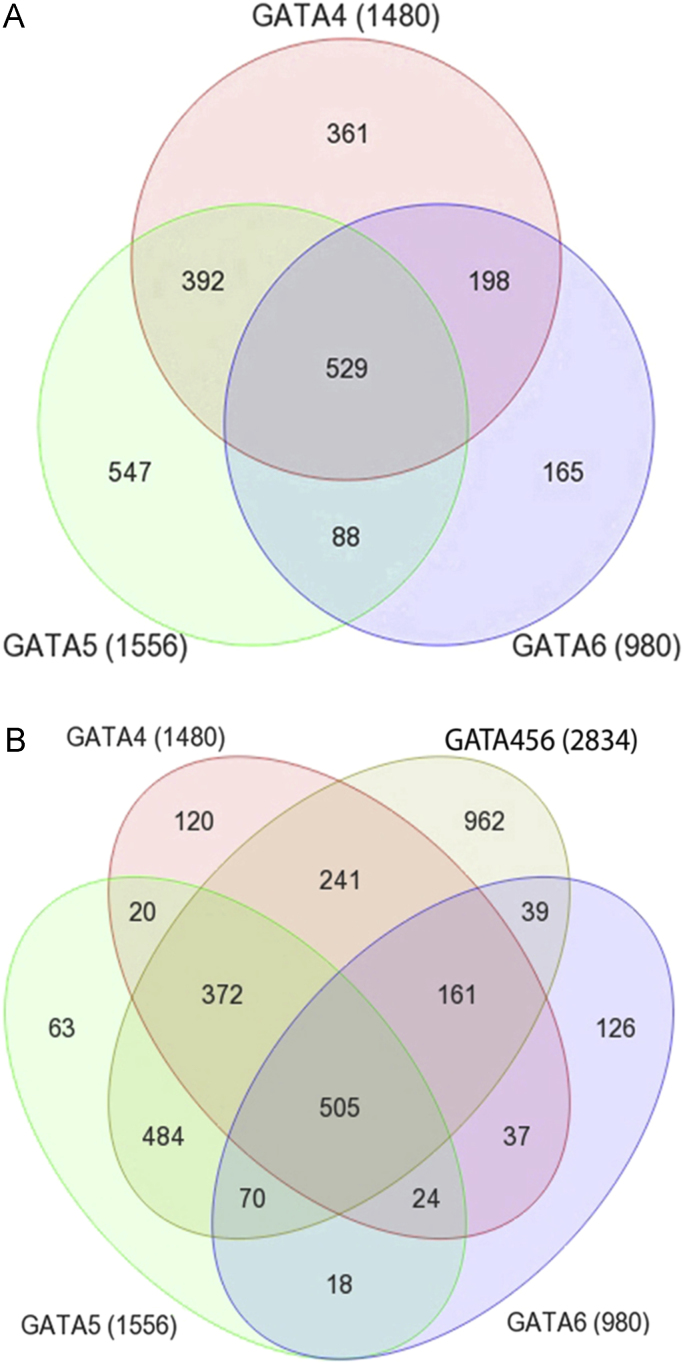
Venn diagrams of numbers of genes that are differentially expressed compared to Activin-injected control with at least a two-fold reduction in expression and an adjusted p value of <0.05. A: gata-dependent genes with decreased expression in single gata4, gata5 or gata6 knockdown, respectively (for list of genes, see Table 1). B: gata-dependent genes with decreased expression in triple gata4, gata5 or gata6 knockdown compared to those with decreased expression in single gata4, gata5 and gata6 knockdown, respectively (for list of genes, see Table 2).